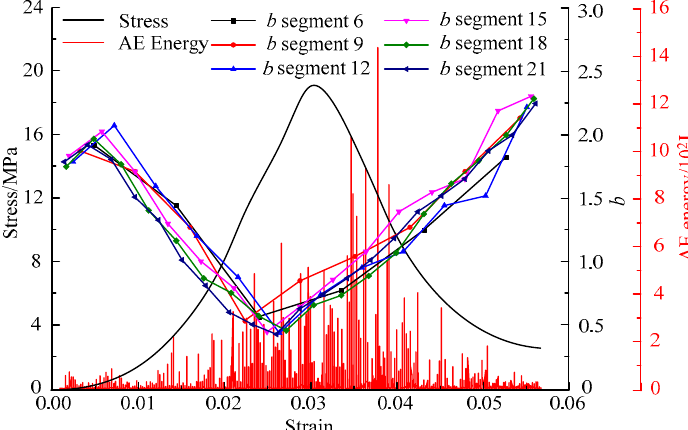
Figure 6. Stress–strain–AE energy and stress–strain– b curves of mortar with sandwich iron and cement–sand ratio 1:1.5. Table 2. Statistical results of N E for each time period.